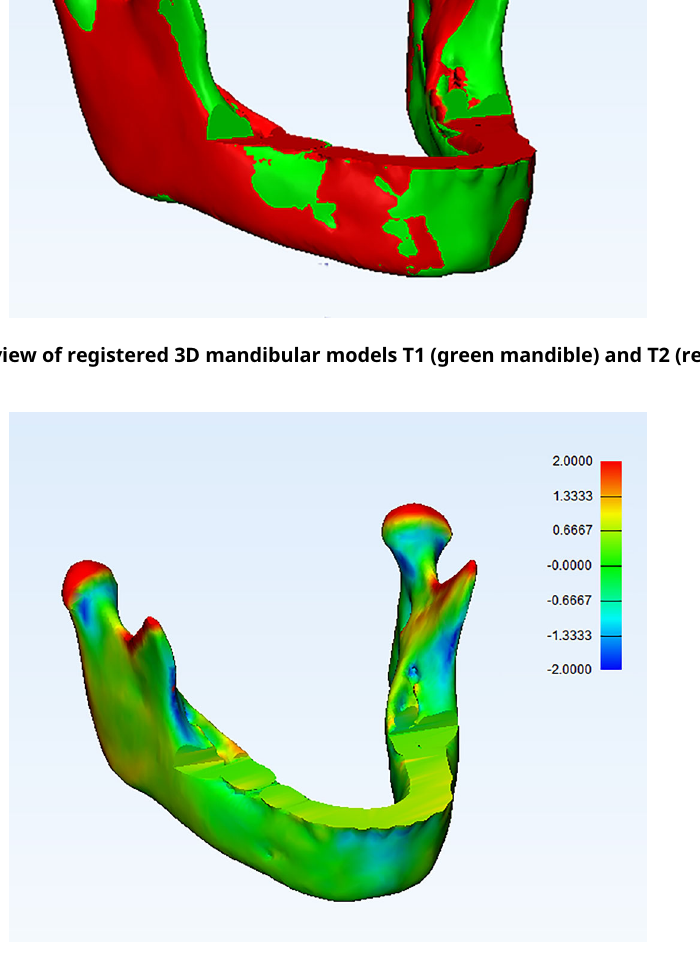
Figure 5. Isometric view of the registered 3D mandibular color-coded map after part analysis between